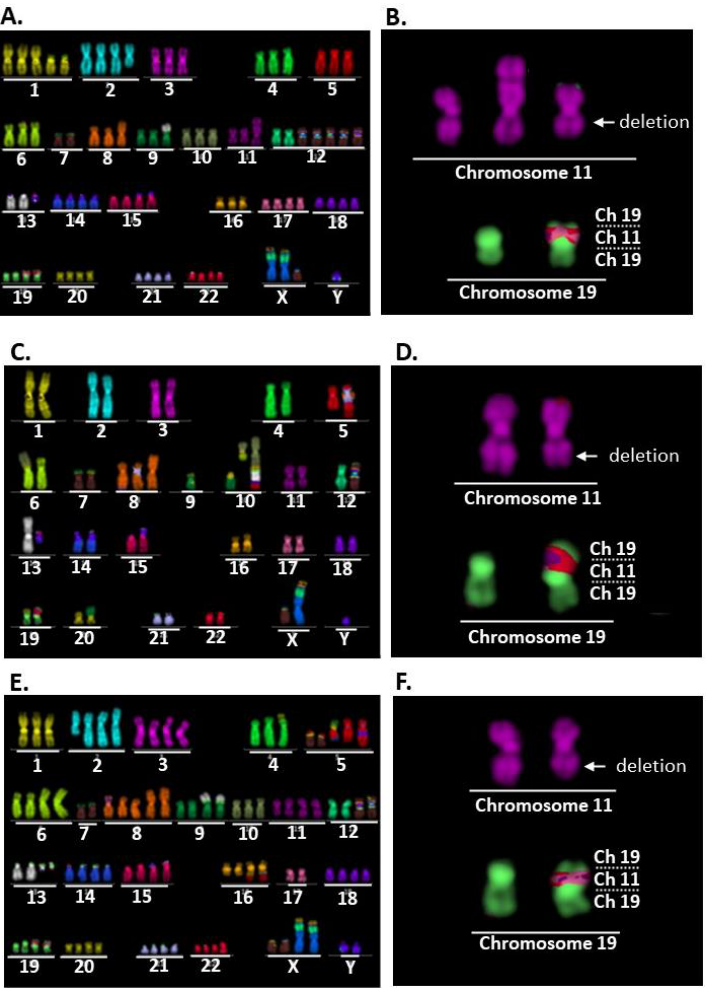
Figure 2. Representative images of multi-color FISH and structural abnormalities of chromosomes 11 and 19 in the established MEC cell lines, AMU-MEC1, AMU-MEC1-R1, and AMU-MEC1-R2. Images of ( A , B ) AMU-MEC1, ( C , D ) AMU-MEC1-R1, and ( E , F ) AMU-MEC1-R2. AMU-MEC1 and AMU-MEC-R2 are hyper-diploid, while AMU-MEC-R1 is near-diploid ( A , C , E ). All three cell lines have der(19)ins(19;11)(p13;?), resulting in the CRTC1-MAML2 chimeric gene ( B , D , F ). White arrows indicate internal deletion loci in the chromosomal arm 11q ( B , D , F ). The karyotype of each cell line is detailed in Supplementary Tables S1 – S3. Ch,